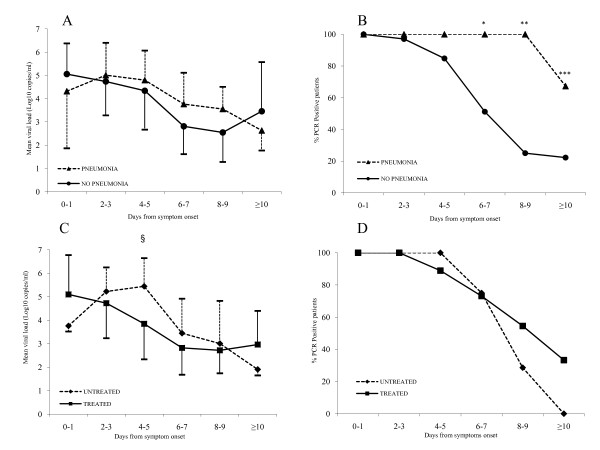
Time course of viral load and duration of viral shedding according to presence of pneumonia and antiviral treatment. Panels A and C: mean values and standard deviation (represented by bars) of influenza A/H1N1pdm in NPS at various time points after symptom onset; panels B and D: proportion of samples positive to influenza A/H1N1pdm PCR according to time from symptom onset. Panels A and B: patients with pneumonia vs. without pneumonia; Panels C and D: treated vs. untreated patients. In panel A the number of samples collected at days 0-1, 2-3, 4-5, 6-7, 8-9 and ≥10 were (for patients with pneumonia) 3, 8, 8, 9, 5, and 21 and (for patients without pneumonia) 8, 21, 30, 7, 14 and 10. In panel C the number of samples collected at days 0-1, 2-3, 4-5, 6-7, 8-9 and ≥10 were (for treated patients) 9, 24, 24, 23, 13 and 29, and (for untreated patients) 2, 5, 14, 13, 6 and 2.* p ≤ 0.010, ** p ≤ 0.010, *** p ≤ 0.010; §: p = 0.002.